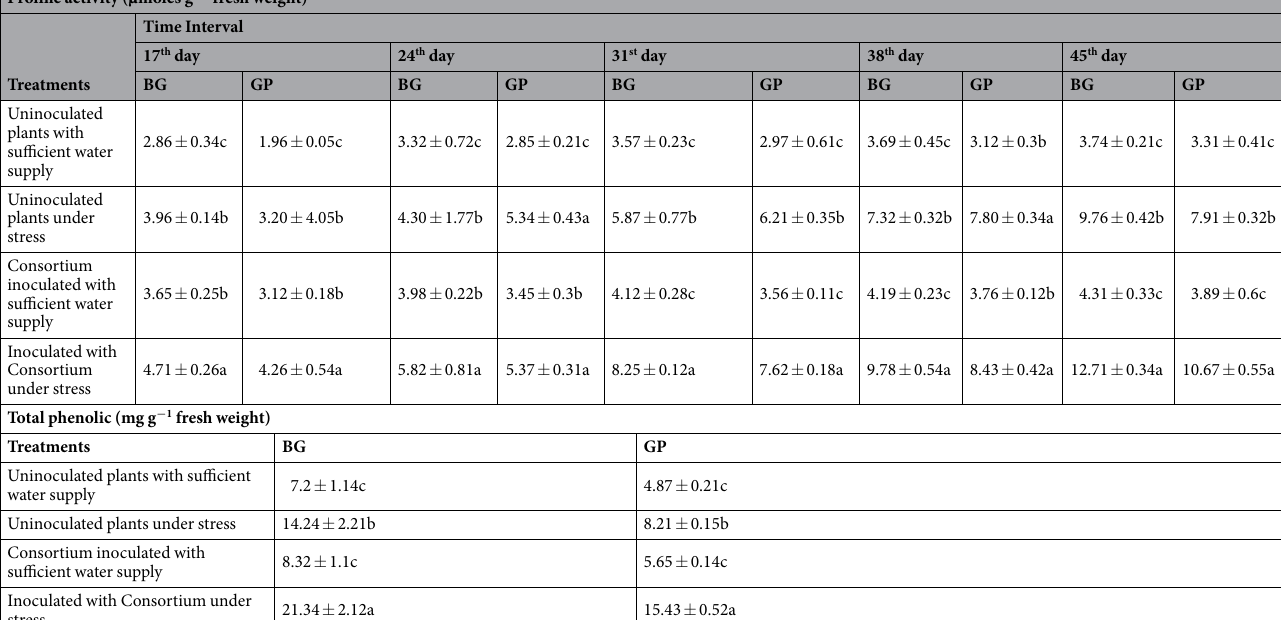
Table 4. Activity of proline and phenolics in black gram and garden pea plants under water stress condition. Proline activity was measured at different interval of time, i.e. 17 th to 45 th days of sowing with seven days of interval. Phenolics activity measured on the 38 th day of sowing. Consortium is the mixture of all the three strains in equal ratio (1:1:1). Two-way ANOVA was performed considering water supply and bacteria inoculation as two independent variables, followed by Tukeys post-test for each treatment. For each figure in a column, values represented by the same lowercase letters are not significantly different at p = 0.05; figures are